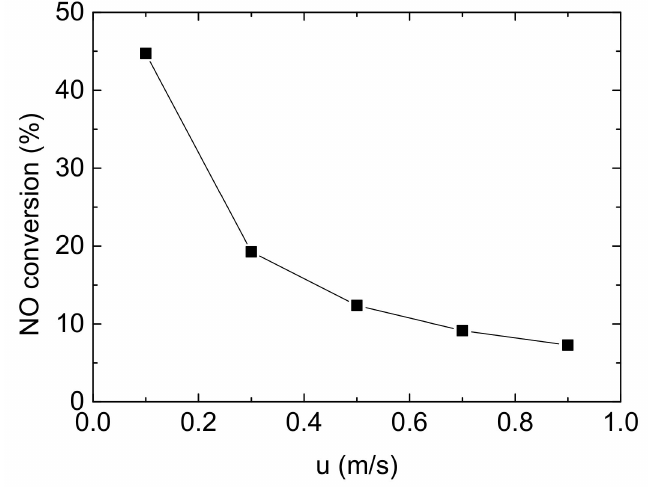
Figure 9. Effect of inlet flow velocity on NO conversion (Reaction temperature T = 150 ◦ C, Concen- tration C NH3 = C NO = 750 ppm, C O2 = 6%, without H 2